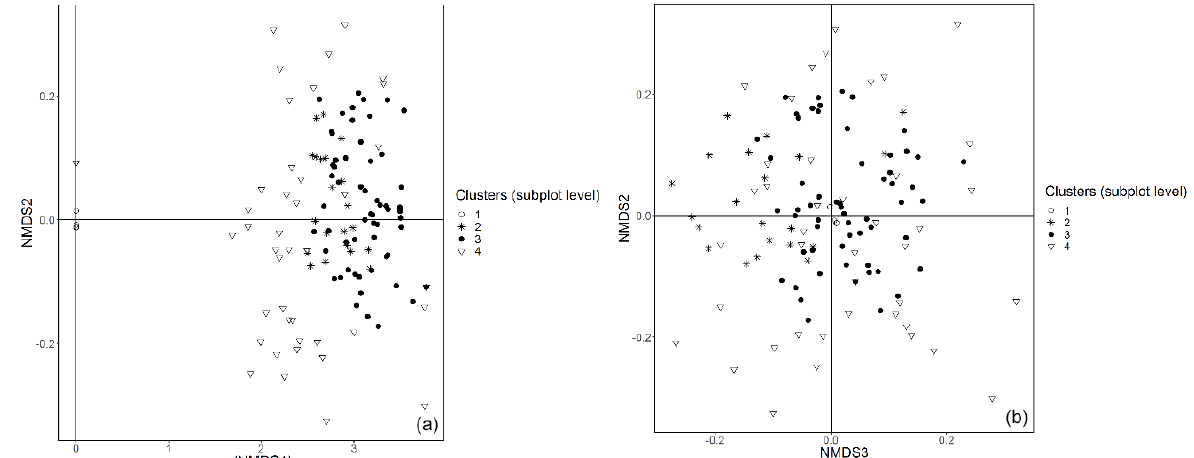
Figure E2. Subplot data – NMDS ordination (axes 1 and 2, a ; axes 2 and 3, b ) of 147 subplots across six sacred forests for understory saplings and shrubs. Subplots are labeled according to the four clusters produced by the cluster analysis (1: Fagus sylvatica ; 2: Carpinus orientalis / Acer monspessulanum ; 3: no significant species; 4: Carpinus betulus / Ostrya carpinifolia ). The first axis of the NMDS ordination was transformed as exp(NMDS) to improve